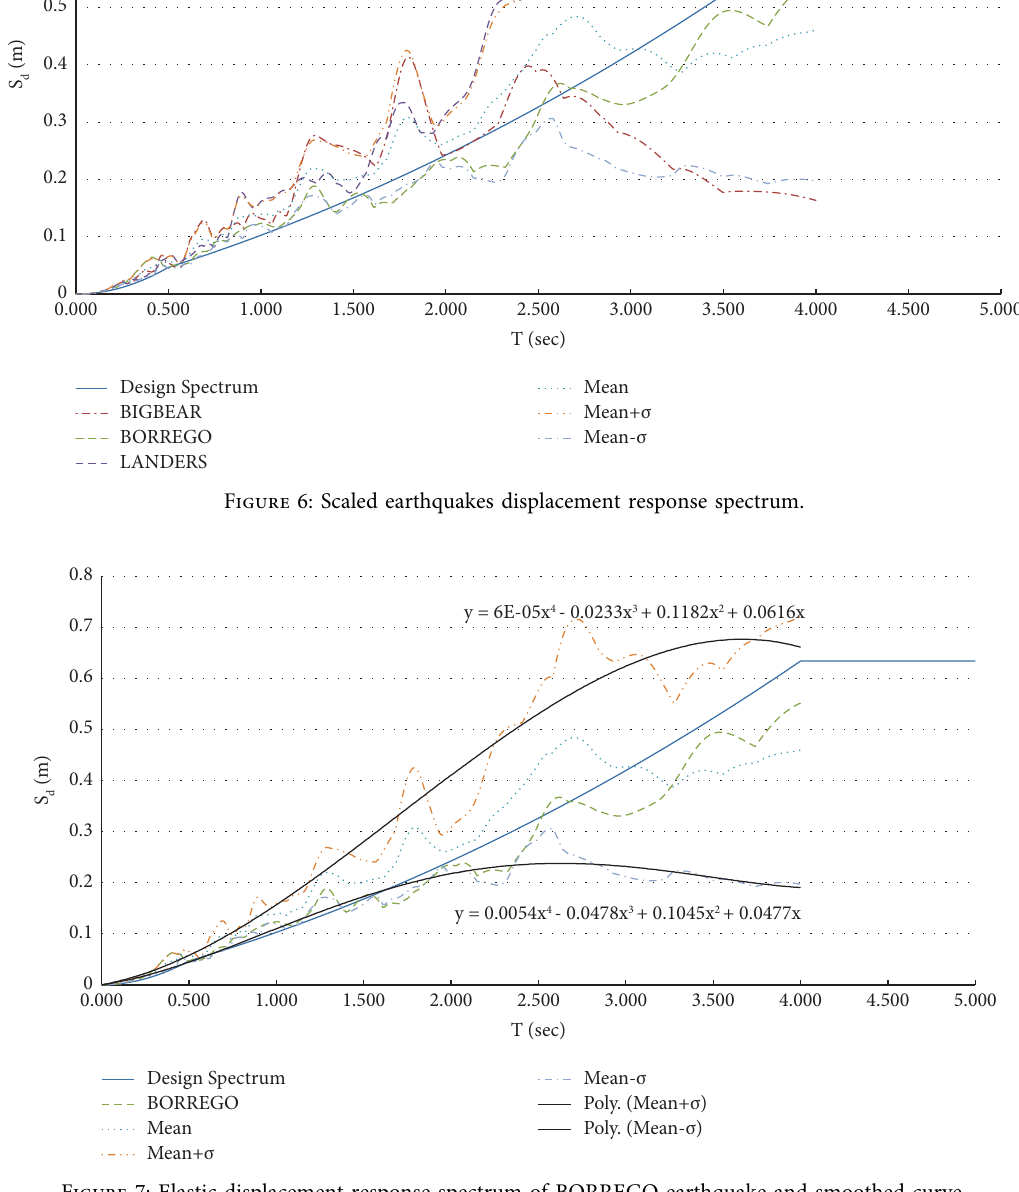
Figure 7: Elastic displacement response spectrum of BORREGO earthquake and smoothed